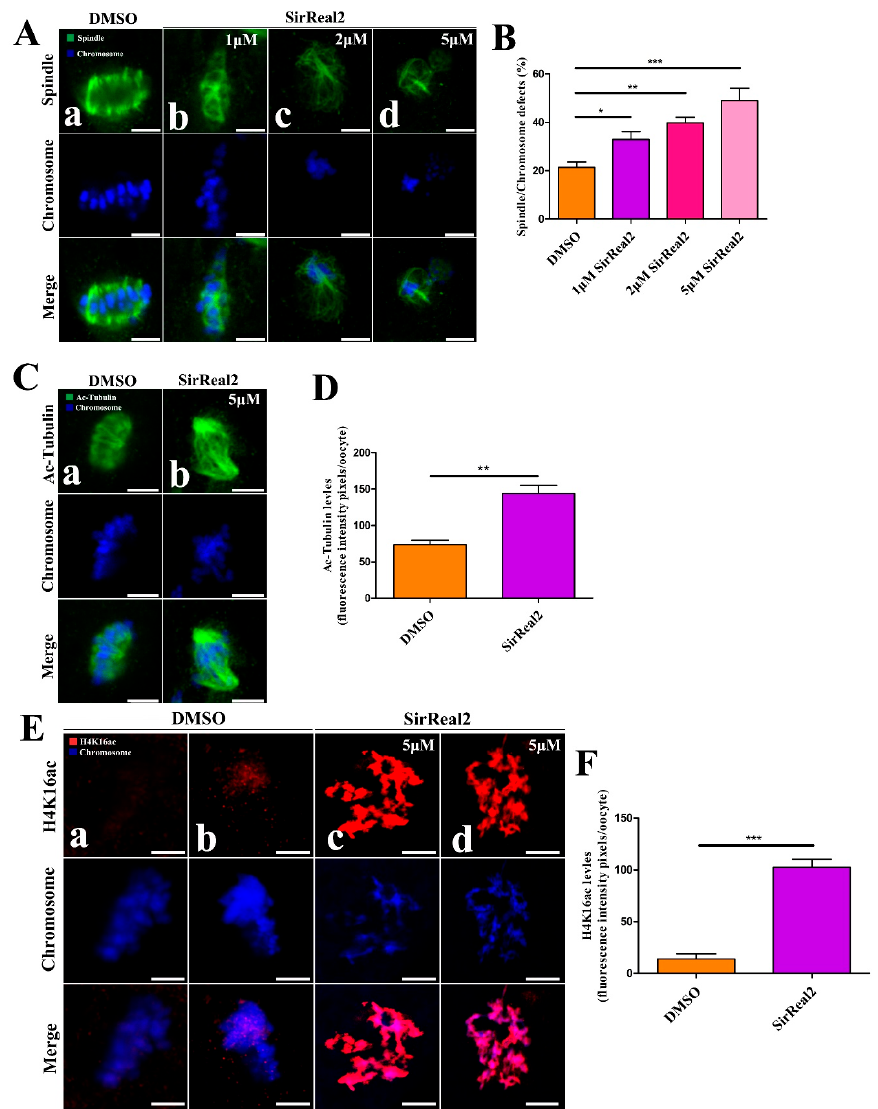
Figure 3. SIRT2 inhibition-induced spindle defects and chromosome misalignment in oocyte meiosis. ( A ) Representative images of spindle morphologies and chromosome alignment in the control (a) and SirReal2-exposed groups (b–d). Oocytes were stained with α -tubulin antibody (green) to visualize the spindles, and counterstained with DAPI (blue) to visualize the chromosomes. Control oocytes presented typical spindle poles and well-aligned chromosomes at the metaphase plate (a), whereas spindle defects and chromosome misalignment were readily observed in SirReal2-exposed oocytes (b–d). Scale bars: 10 µ m. ( B ) Quantification of control and SirReal2-exposed groups with spindle/chromosome defects. Oocytes with disorganized spindles and misaligned chromosomes were the result of spindle/chromosome defects. The spindle/chromosome defects in DMSO ( n = 88), 1 µ M SirReal2 ( n = 87), 2 µ M SirReal2 ( n = 90), 5 µ M SirReal2 ( n = 85) were evaluated, respectively. ( C ) Representative images of acetylated α -tubulin in the control (a) and 5 µ M SirReal2-exposed groups (b). Scale bars: 10 µ m. ( D ) Quantification of the acetylated α -tubulin fluorescence intensity shown in ( C ). ( E ) Representative images of H4K16ac in the control (a,b) and 5 µ M SirReal2-exposed (c,d) oocytes. Oocytes were stained with H4K16ac antibody (red) and counterstained with DAPI to visualize chromosomes (blue). Scale bars: 5 µ m. ( F ) Quantification of H4K16ac was analyzed with Image-Pro Plus software. Data are expressed as the mean percentage ± SEM from three independent experiments in which at least 150 oocytes were analyzed. * p < 0.05, ** p < 0.01, *** p < 0.001, comparing the indicated